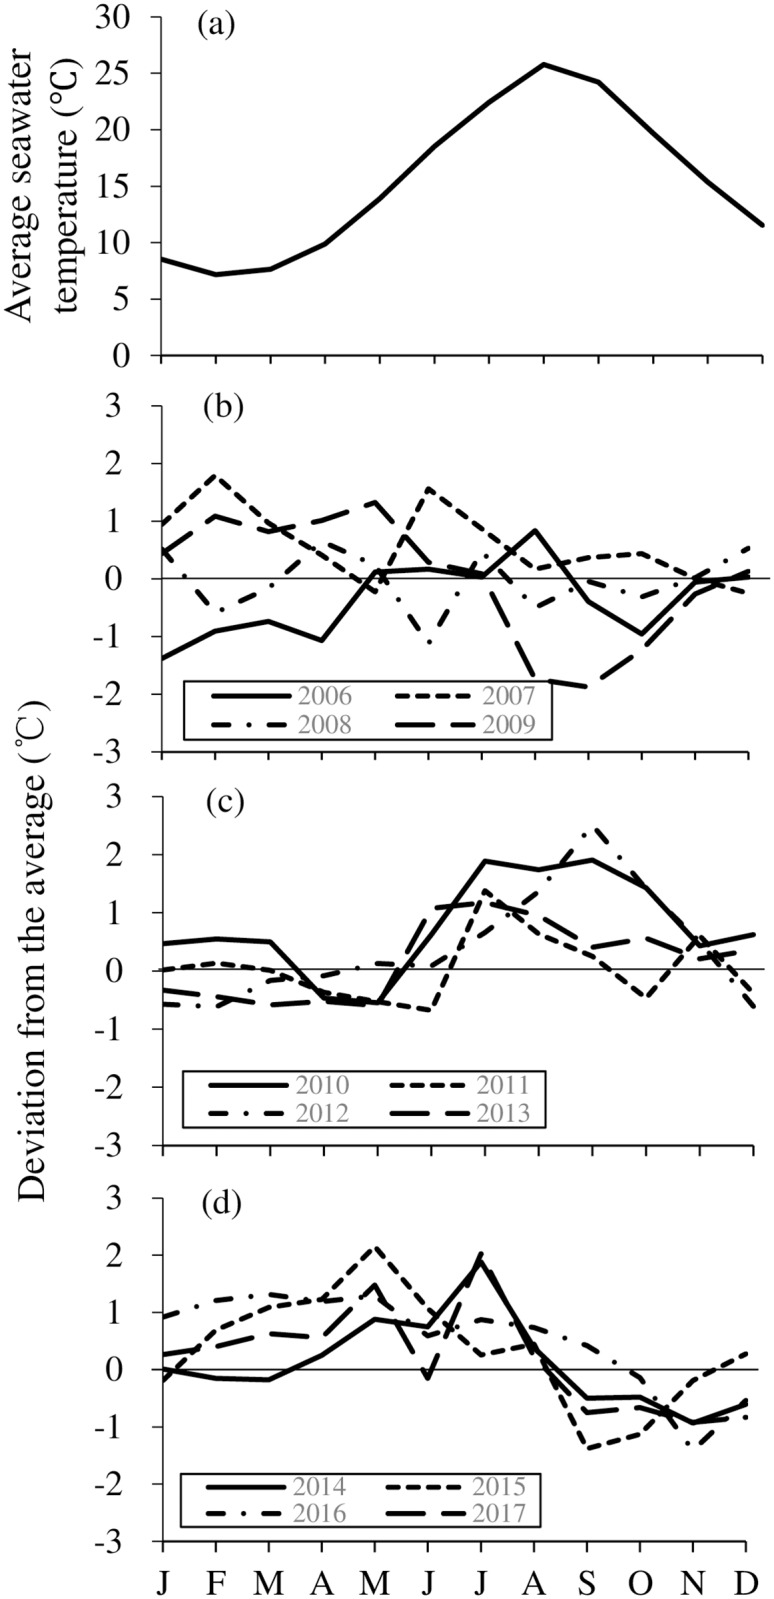
Sea surface temperature off Unosaki (39°51´N, 139°48´E), along the Oga Peninsula, Akita Prefecture.Monthly averages for 34 years (1984–2017) (a), and deviations from the average from 2006 to 2009 (b), 2010 to 2013 (c) and 2014 to 2017 (d). X-axis represents months from January (J) to December (D).